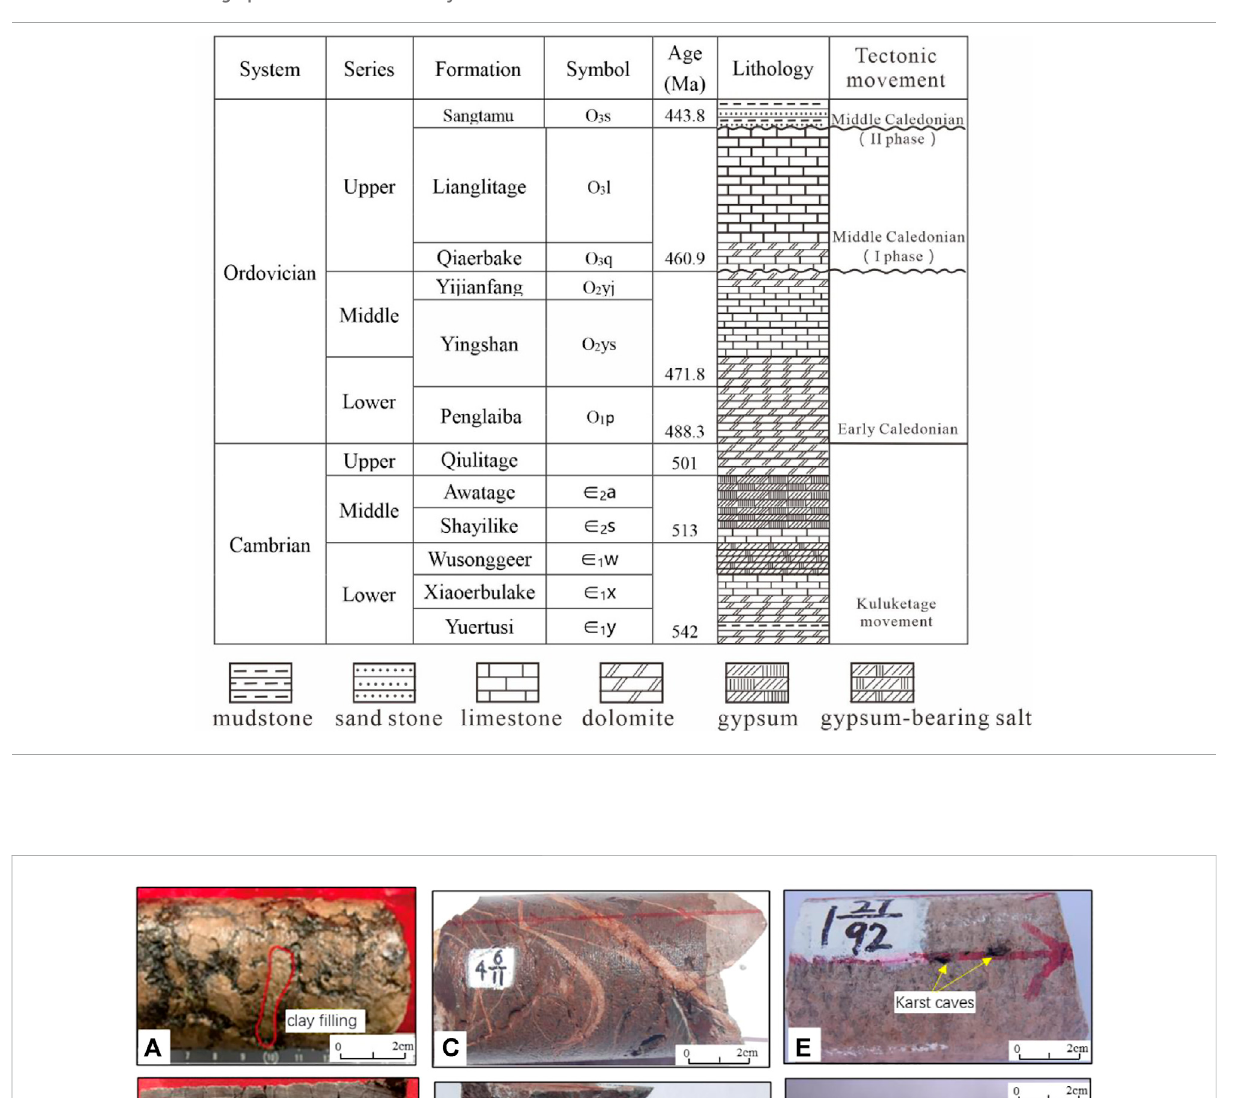
TABLE 1 Ordovician stratigraphic column of the study